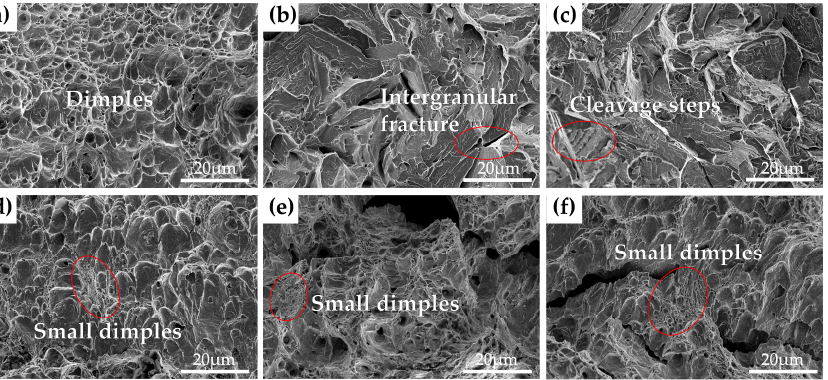
Figure 4. The impact fracture morphologies of ( a ) 0Cu ‐ steel tempered at 450 °C, ( b ) 1Cu ‐ steel tempered at 450 °C, ( c ) 3Cu ‐ steel tempered at 450 °C, ( d ) 0Cu ‐ steel tempered at 600 °C, ( e ) 1Cu ‐ steel at tempered 600 °C, and ( f ) 3Cu ‐ steel tempered at 600 °C.